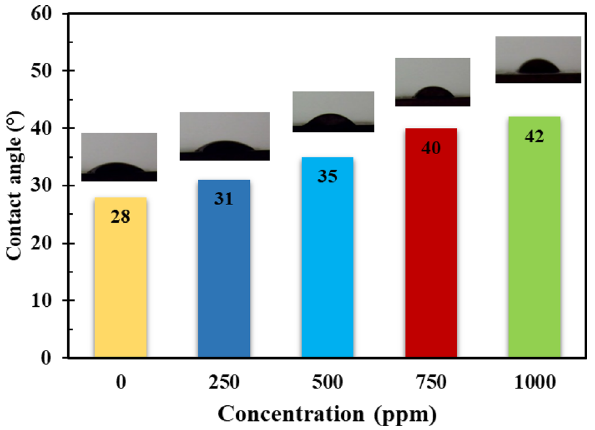
Figure 12. Contact angle of the surface of MS immersed in 1 M HCl solution containing various concentrations of DPH after 4